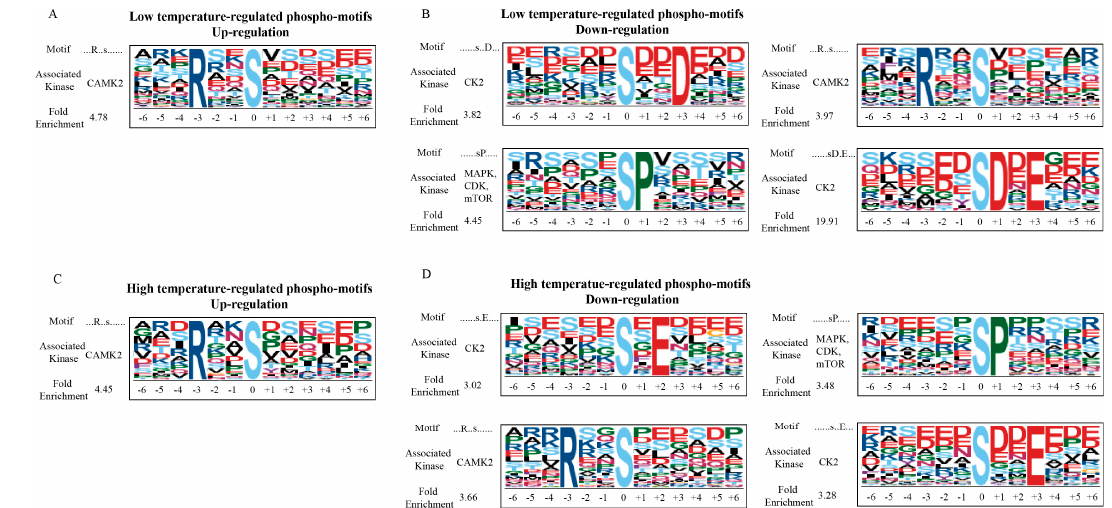
Figure 5. The features of enriched phosphorylation motifs. (A) Enriched phosphorylation motif of peptides upregulated at 15 °C. (B) Enriched phosphorylation motifs of peptide downregulated at 15 °C. (C) Enriched phosphorylation motif of peptides upregulated at 25 °C. (D) Enriched phosphorylation motifs of peptide downregulated at 25 °C.